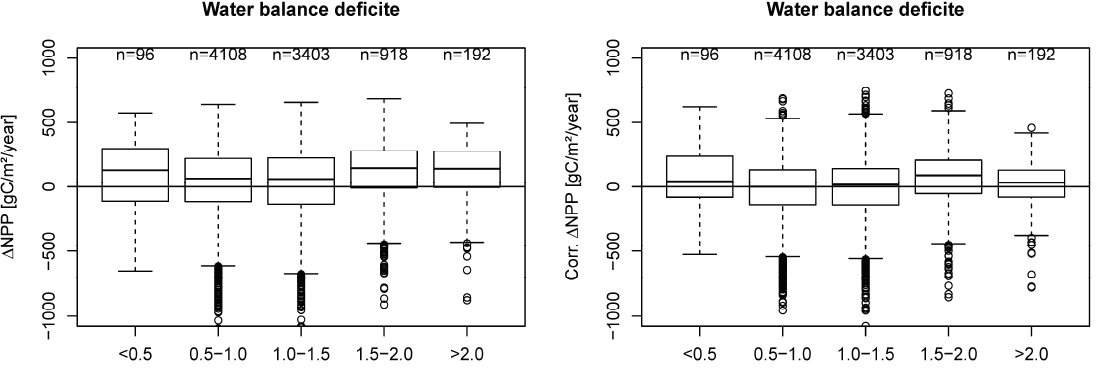
Figure 8. Difference between MODIS NPP and NFI NPP (MODIS minus NFI) grouped by Water balance deficit. Left original MODIS NPP ( ∆ NPP) is used, right the detrended MODIS NPP (Corr. ∆ NPP) is used. Properties of illustration analogous to Figure